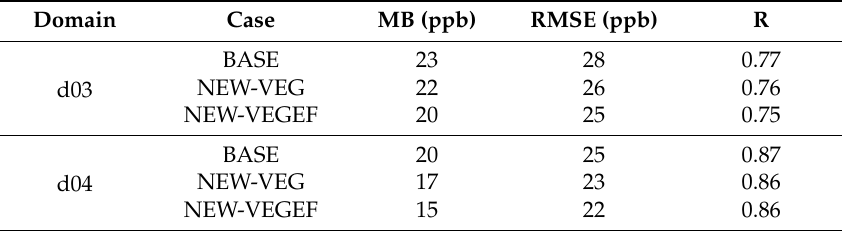
Table 4. Statistical analysis of model performance for daily surface MDA8O3 during the target period in d03 and d04.